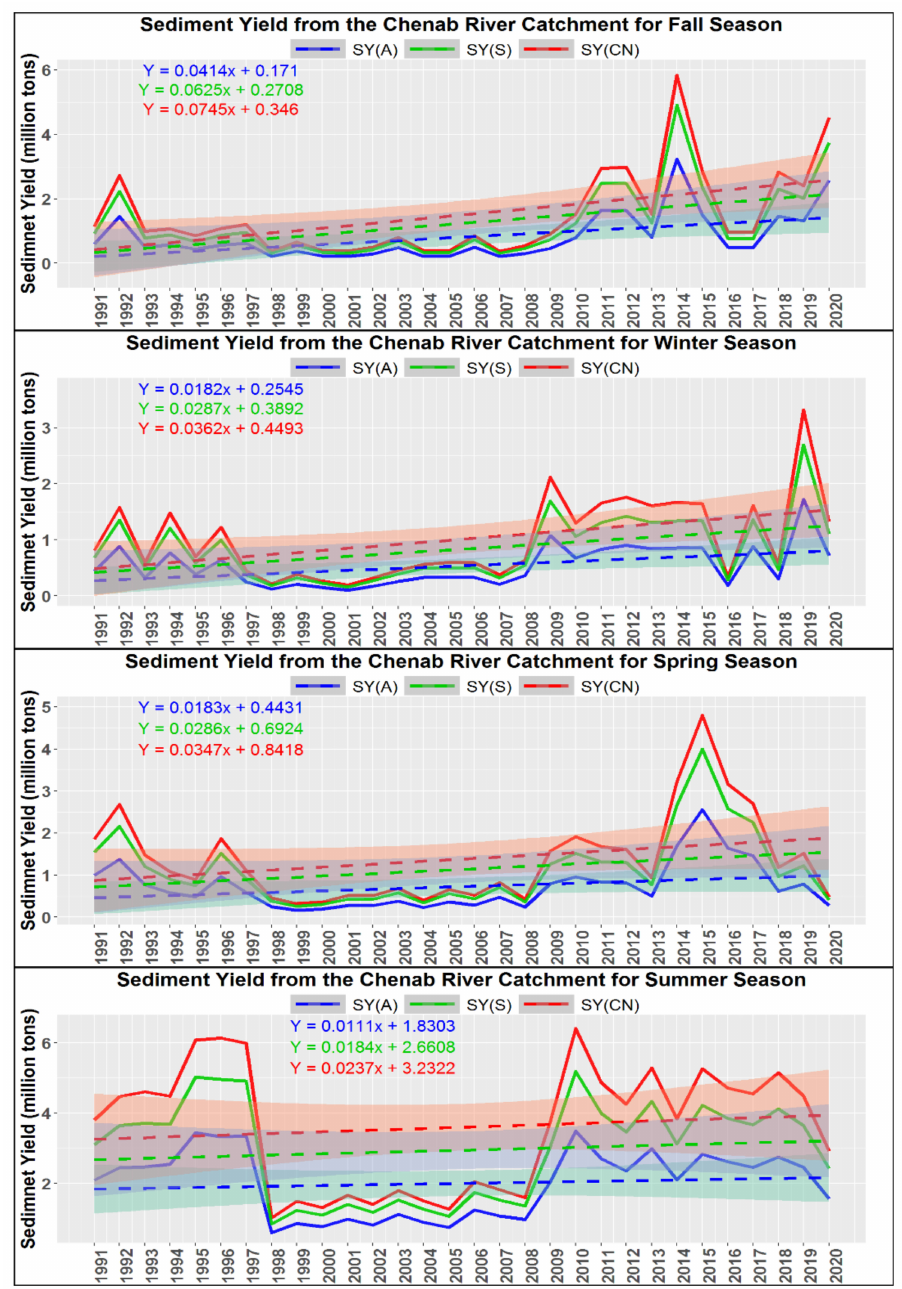
Figure 13. Sediment yield from the Chenab river catchment for fall, winter, spring, and